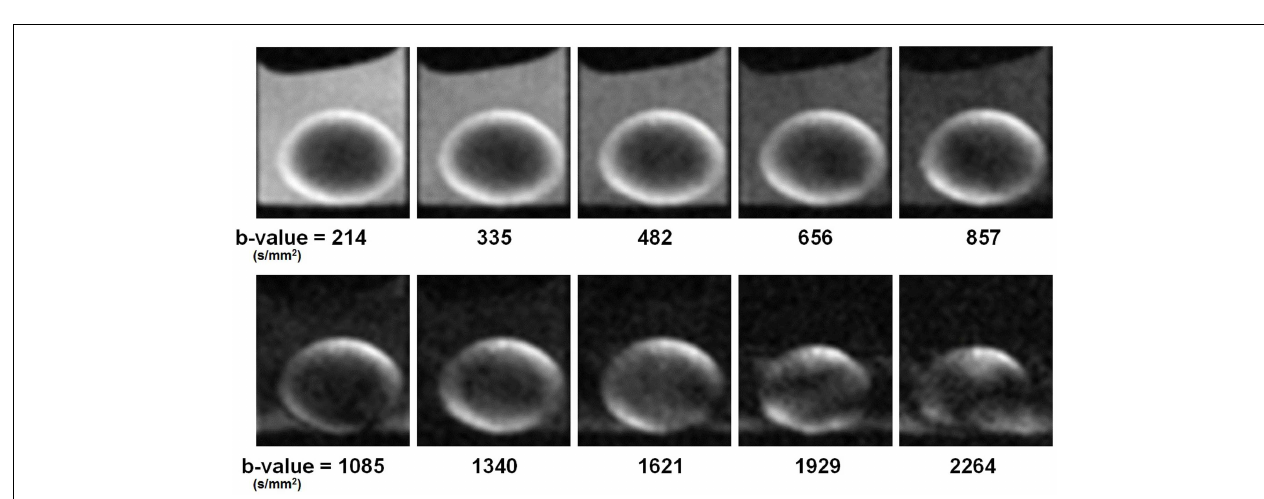
FIGURE 4 | Ocular lens imaged using a diffusion weighting pulse sequence, varying b -value. Ten different b -values were tested in the first set of diffusion-weighted experiments (see Materials and Methods). Image slices were positioned to pass through the visual axis of the lens (see Figures 1B,C ).The direction of the diffusion gradients (see Figure 2 ) was from bottom-left to top-right in the plane of the images.